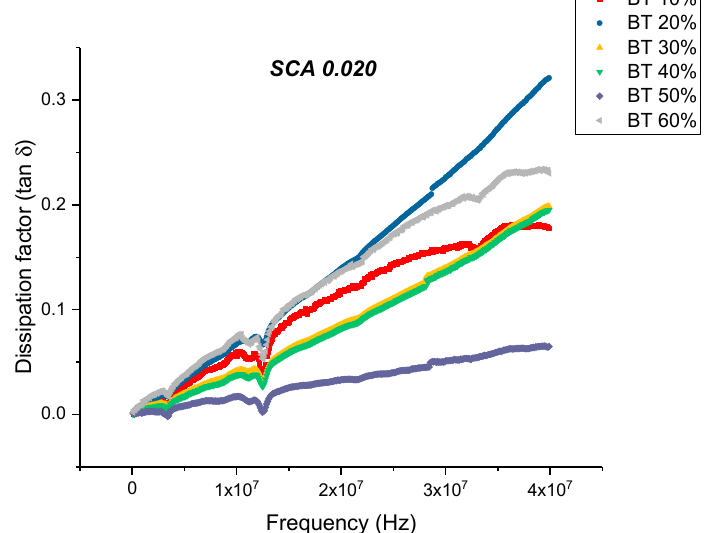
Figure 14. The dissipation factor of the BaTiO 3 -epoxy composite that were fabricated using BaTiO 3 nanoparticles which were surface modified using 0.020 SCA is plotted as a function of frequency where the volume fraction of BaTiO 3 is varied from 0.1 to 0.6. The maximum value is 0.136 for BaTiO 3 at 0.6 volume fraction.